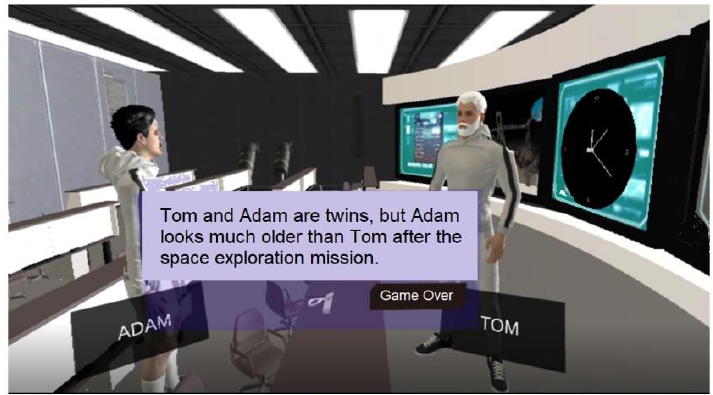
Figure 12. Adam returning to Earth after completing the mission.